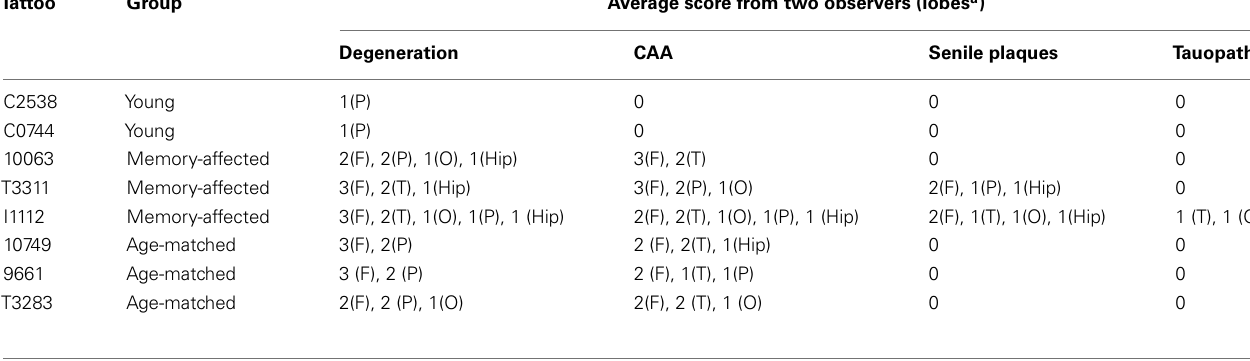
Table 3 | Histopathology findings and summary of the scores